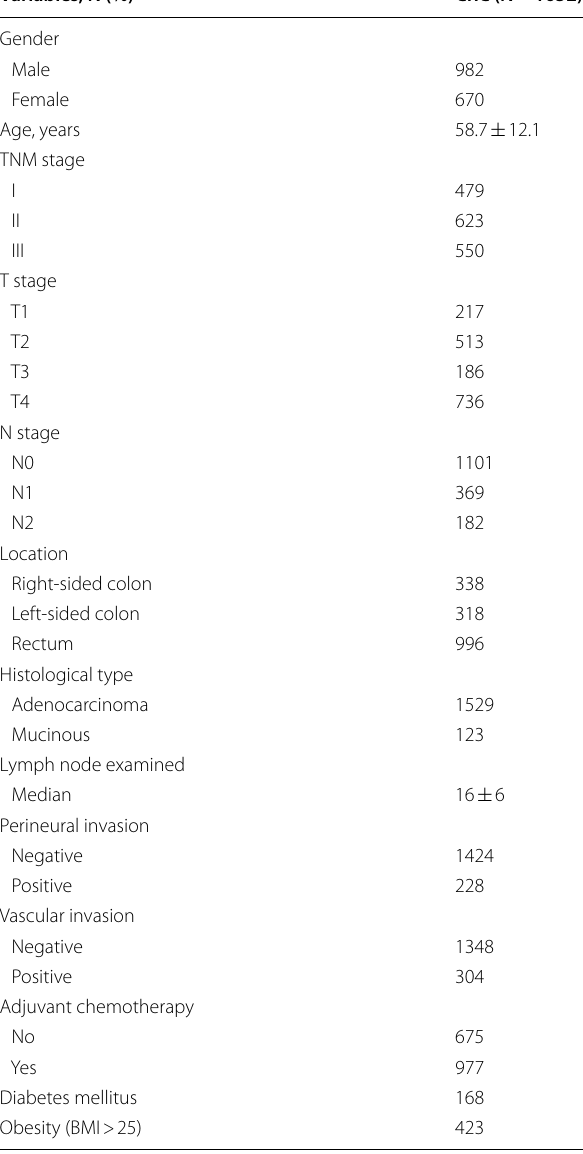
Table 1 Baseline characteristics of the consecutive CRC patients with radical surgery